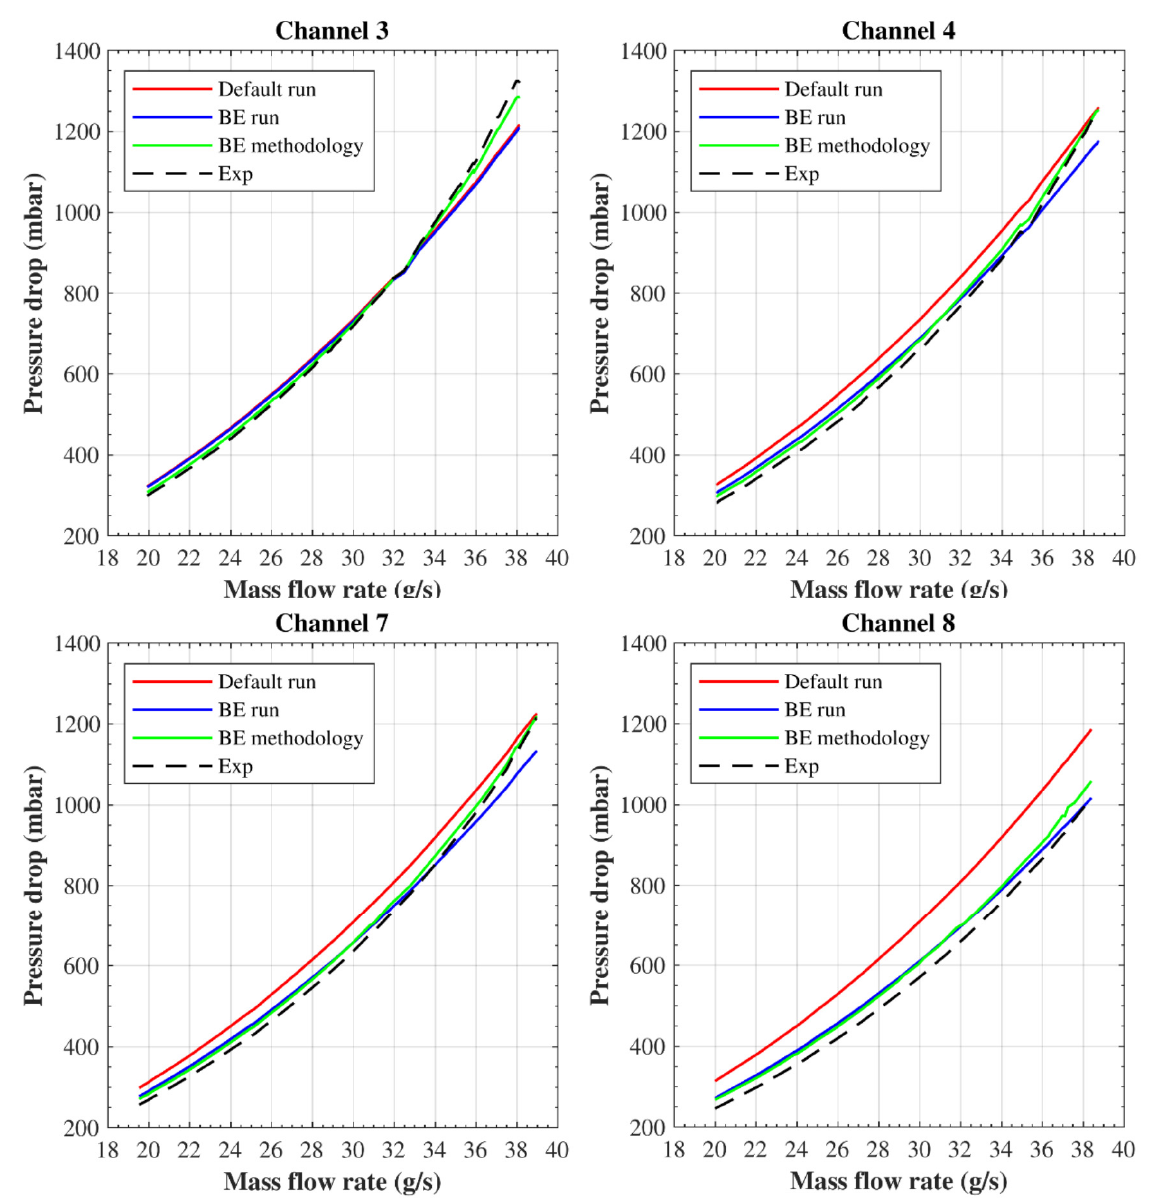
Figure 5. Results of the pressure drop characterization tests: Channels 3 and 4 (horizontal inlet), and Channels 7 and 8 (vertical